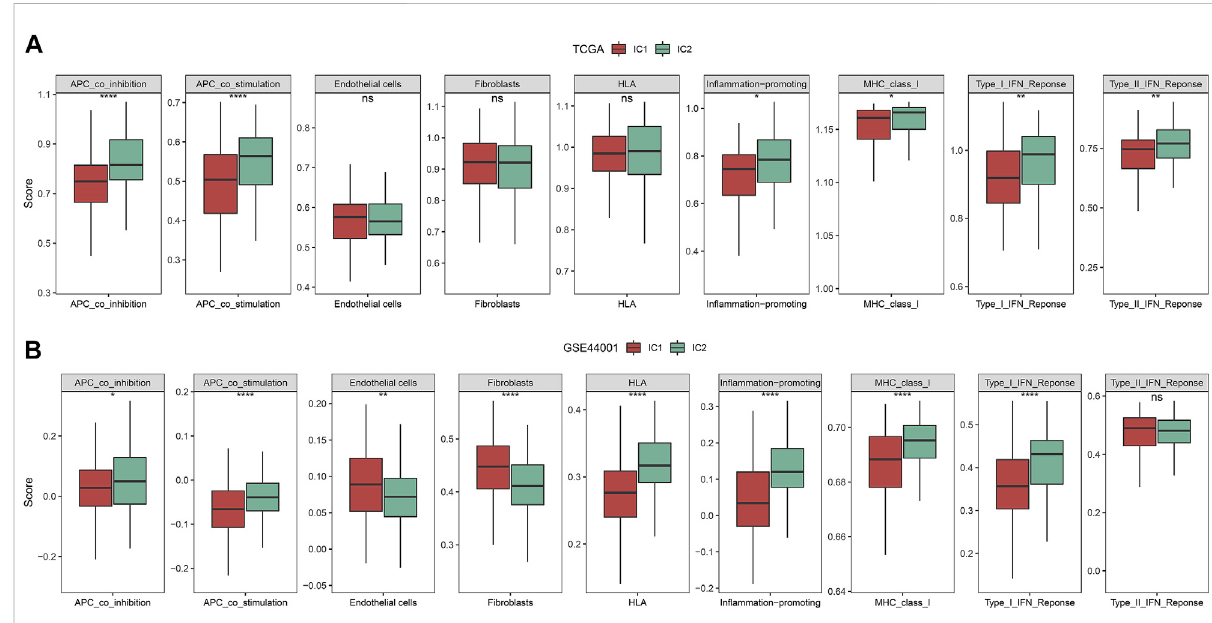
FIGURE 4 Immune subtypes with distinct immune-relevant pathways. (A,B) The activity ofimmune-relevant pathwaysin IC1and IC2 immune subtypes in the TCGA and GSE44001 datasets (ns, no signi fi cance; * p < 0.05; ** p < 0.01; **** p <